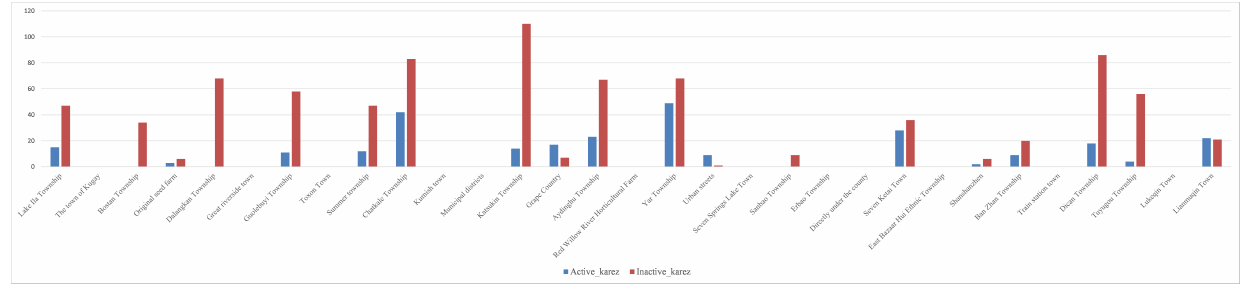
Figure 7. Comparison of the number of active karezes and inactive karezes in 31 townships in the Turpan Basin in 2011.